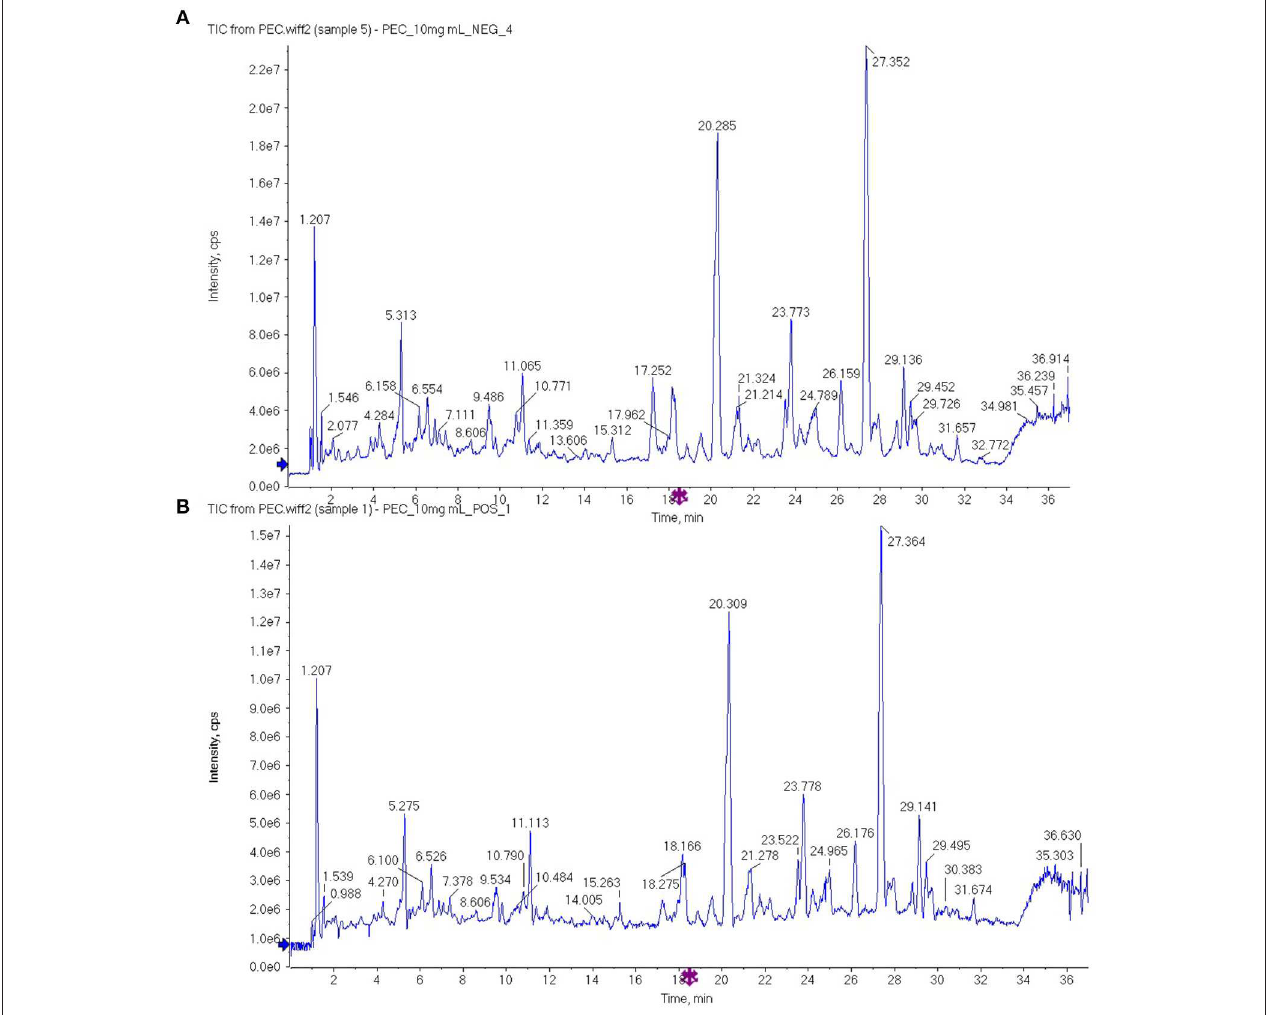
FIGURE 1 | The total ion flow diagram of PEC by UHPLC-Q/TOF-MS in (A) negative ion mode and (B) positive ion